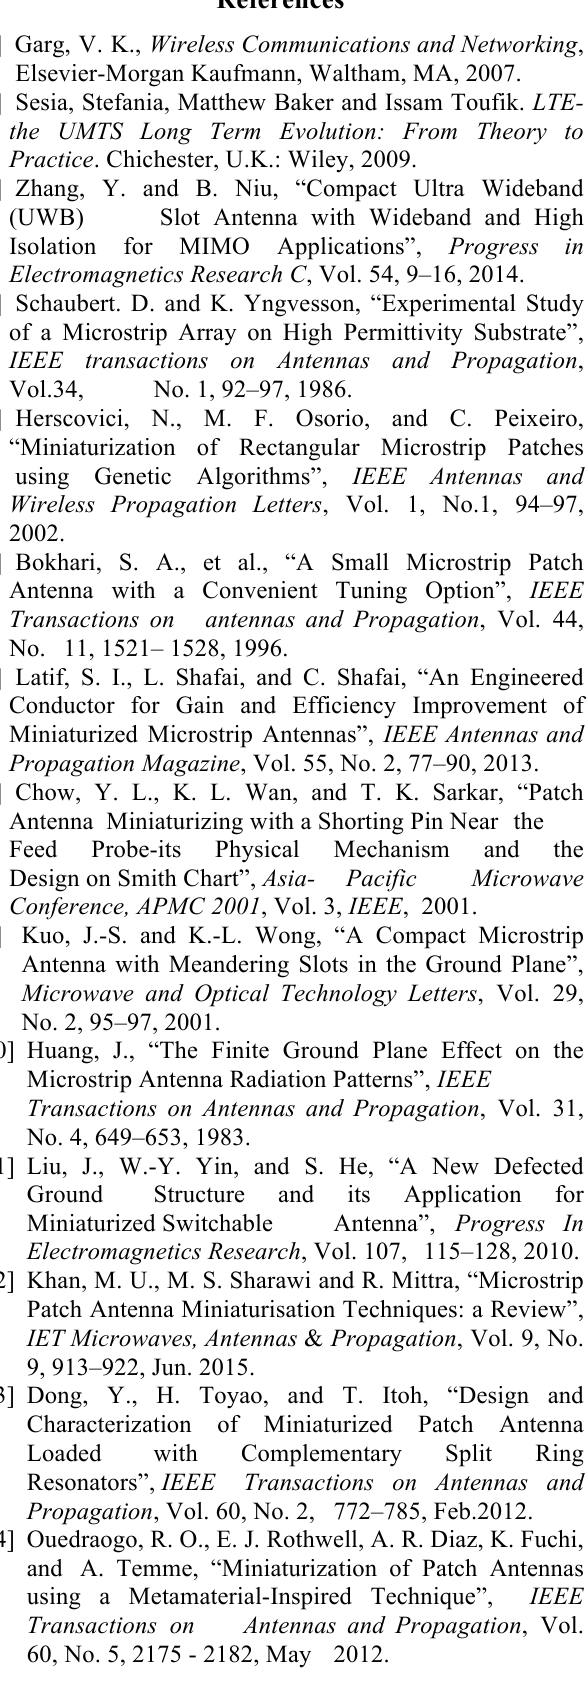
The realized gain gets reduced to -29 dB without